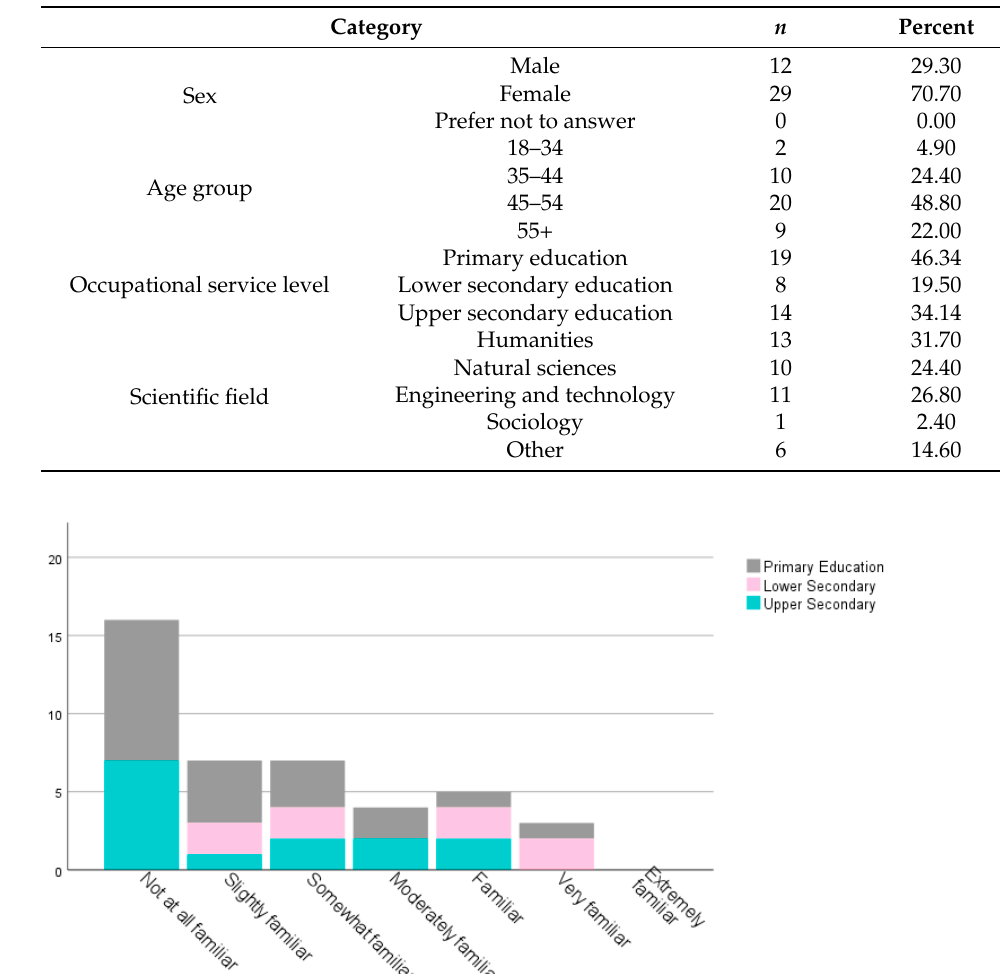
Table 1. Participants’ demographic information.